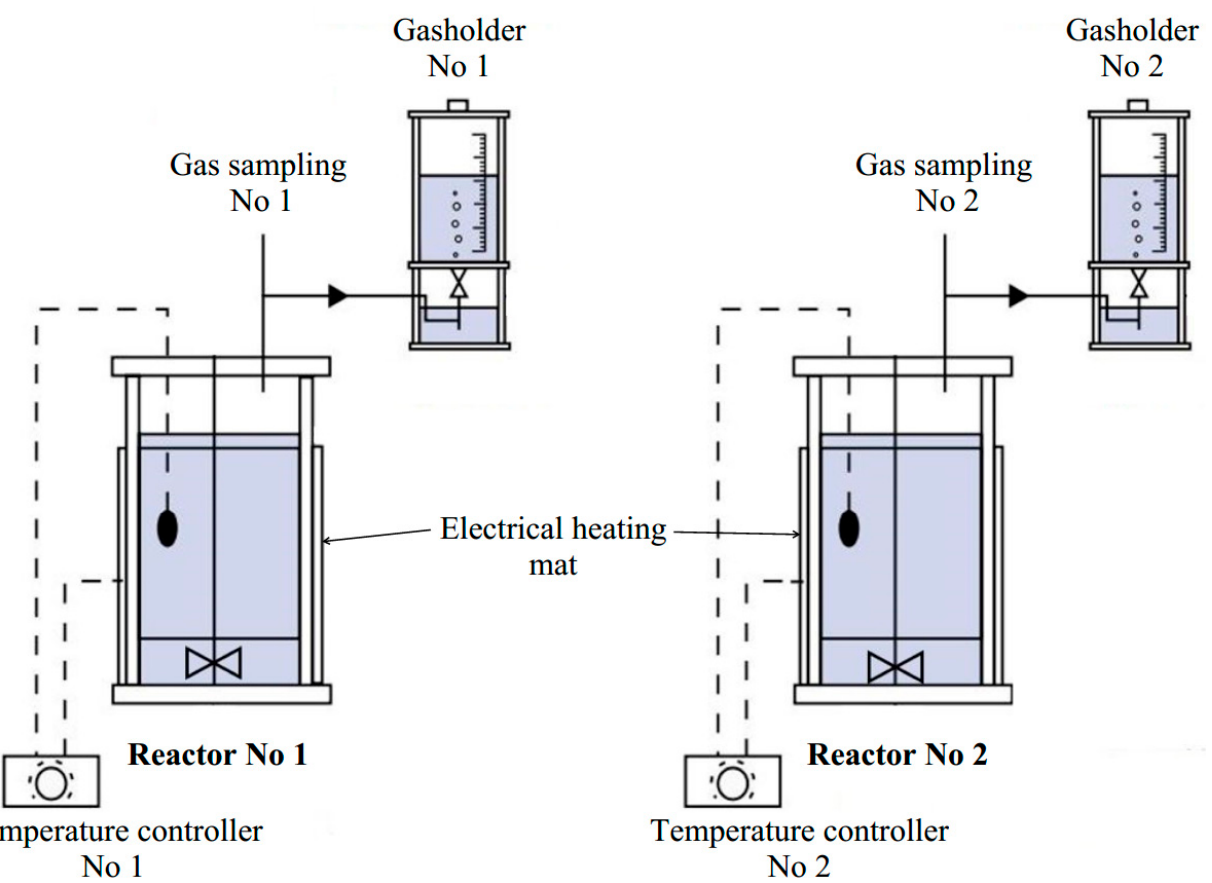
Figure 2. Model “W8 Arm fi eld Ltd.”.